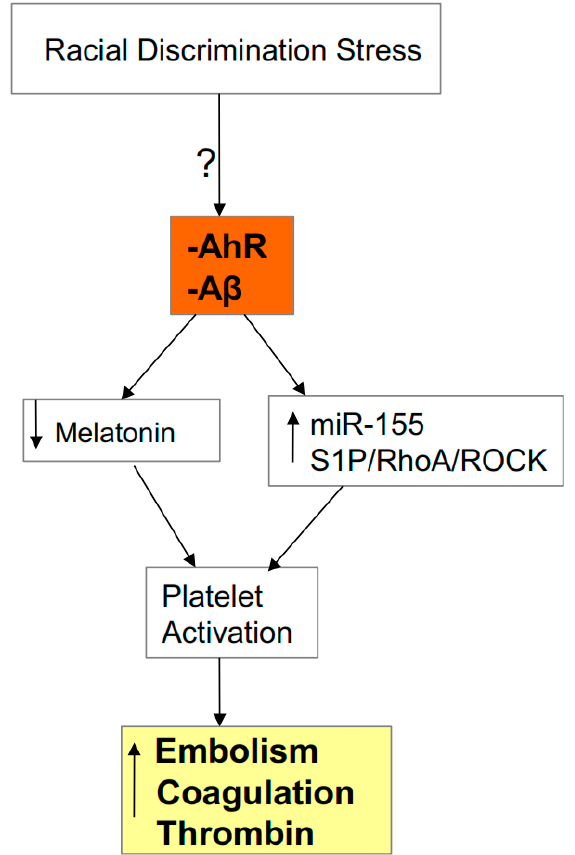
Figure 5. AhR activation and heightened A β levels in the elderly will contribute to platelet activation via decreased melatonin and upregulation of microRNA (miR)-155 and the S1P3r/RhoA/ROCK pathway. The resultant increase in coagulation, thrombin and new embolism formation contribute to SARS-CoV-2 severity/fatality. Racial discrimination stressors may contribute to such processes, given the heightened association of embolism-linked fatalities in African-American deaths during surgery for other types of medical